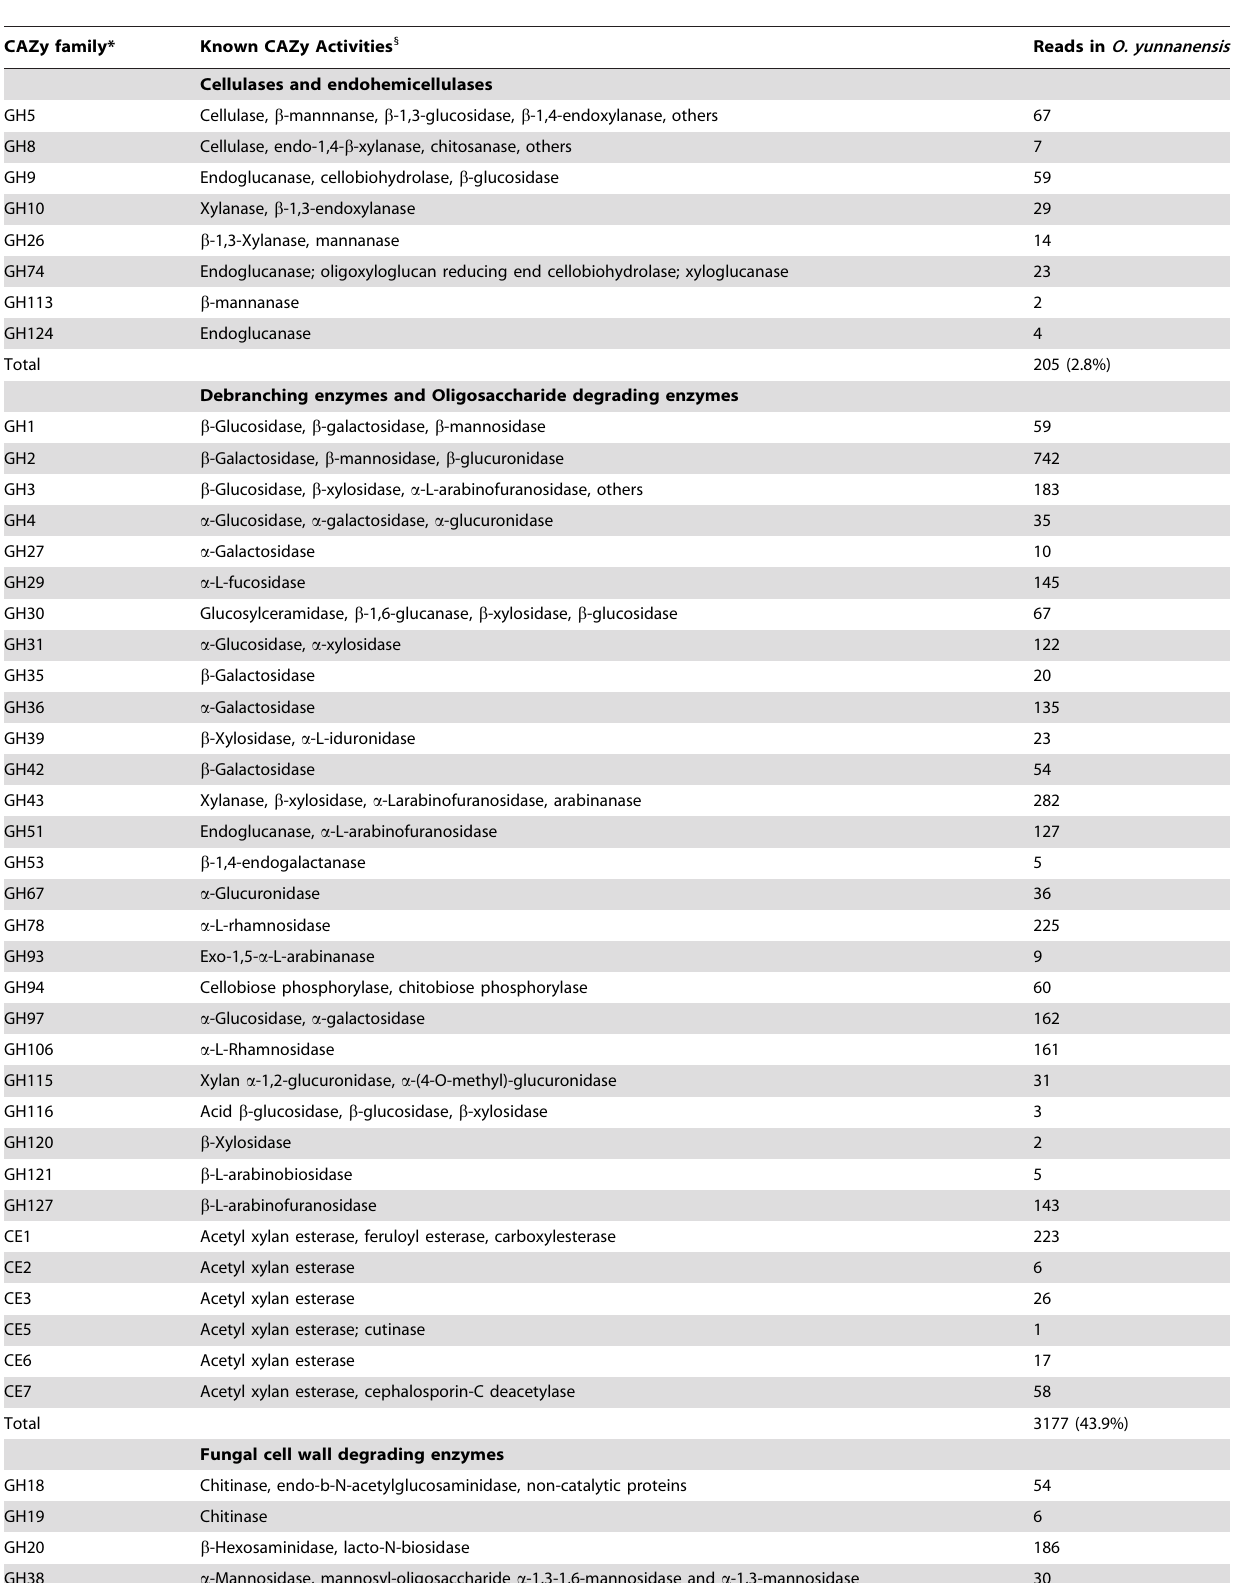
Table 3. Selected carbohydrate-active gene modules detected in the fungus-cultivating termite gut metagenome.